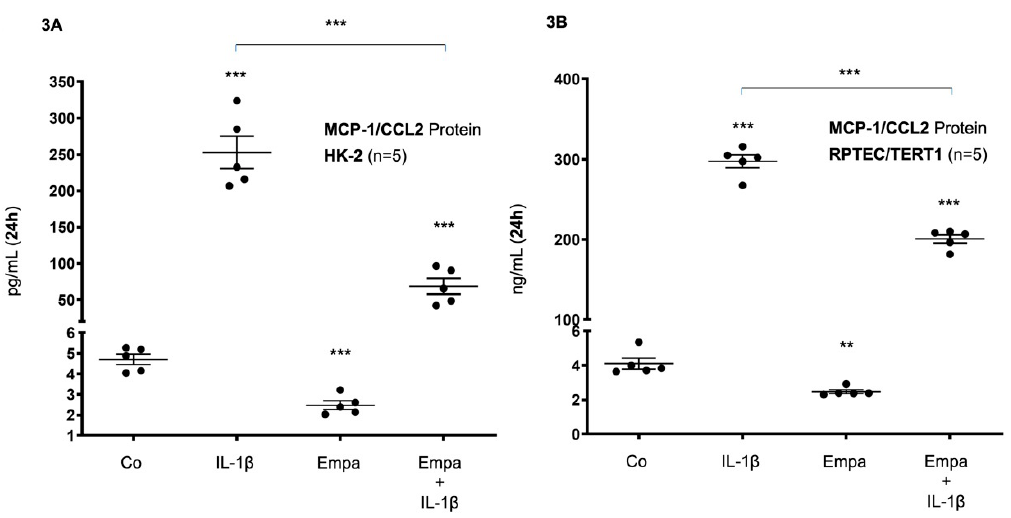
Figure 3. Inhibitory effect of empagliflozin on basal and IL-1 β -induced MCP-1/CCL-2 protein expression in human proximal tubular cells . HPTCs were serum- and supplement-starved for 24 h and then stimulated for 24 h with IL-1 β (10 ng/mL), 500 nM Empa, or a combination of Empa (500 nM) and IL-1 β (10 ng/mL). Controls (Co) were left unstimulated for 24 h ( A , B ). Cell supernatants from n = 5 independent experiments were used for ELISA. Data are presented as concentrations when compared with MCP-1/CCL2 control levels. For each experimental condition, data of five independent experiments are presented as dots in scatter plot graphs with the respective mean ± SEM bars. ( A ) In HK-2 cells, IL-1 β (10 ng/mL) induced MCP-1/CCL2 protein expression 54-fold (*** p < 0.001 compared with unstimulated control cells). Empa (500 nM) downregulated basal MCP-1/CCL2 protein expression by 0.53-fold (*** p < 0.001, compared with unstimulated control cells). Administration of Empa in the presence of IL-1 β resulted in a 0.27-fold inhibition of IL-1 β -induced MCP-1/CCL2 protein expression (*** p < 0.001 when compared with IL-1 β -stimulated cells). ( B ) In RPTEC/TERT1 cells, IL-1 β (10 ng/mL) induced MCP-1/CCL2 protein expression 73-fold (*** p < 0.001 compared with unstimulated control cells). Empa (500 nM) downregulated basal MCP-1/CCL2 protein expression by 0.6–fold (** p < 0.01, compared with unstimulated control cells). Administration of Empa in the presence of IL-1 β led to a 0.67-fold inhibition of IL-1 β -induced MCP-1/CCL2 protein expression (*** p < 0.001 when compared with IL-1 β -stimulated cells).